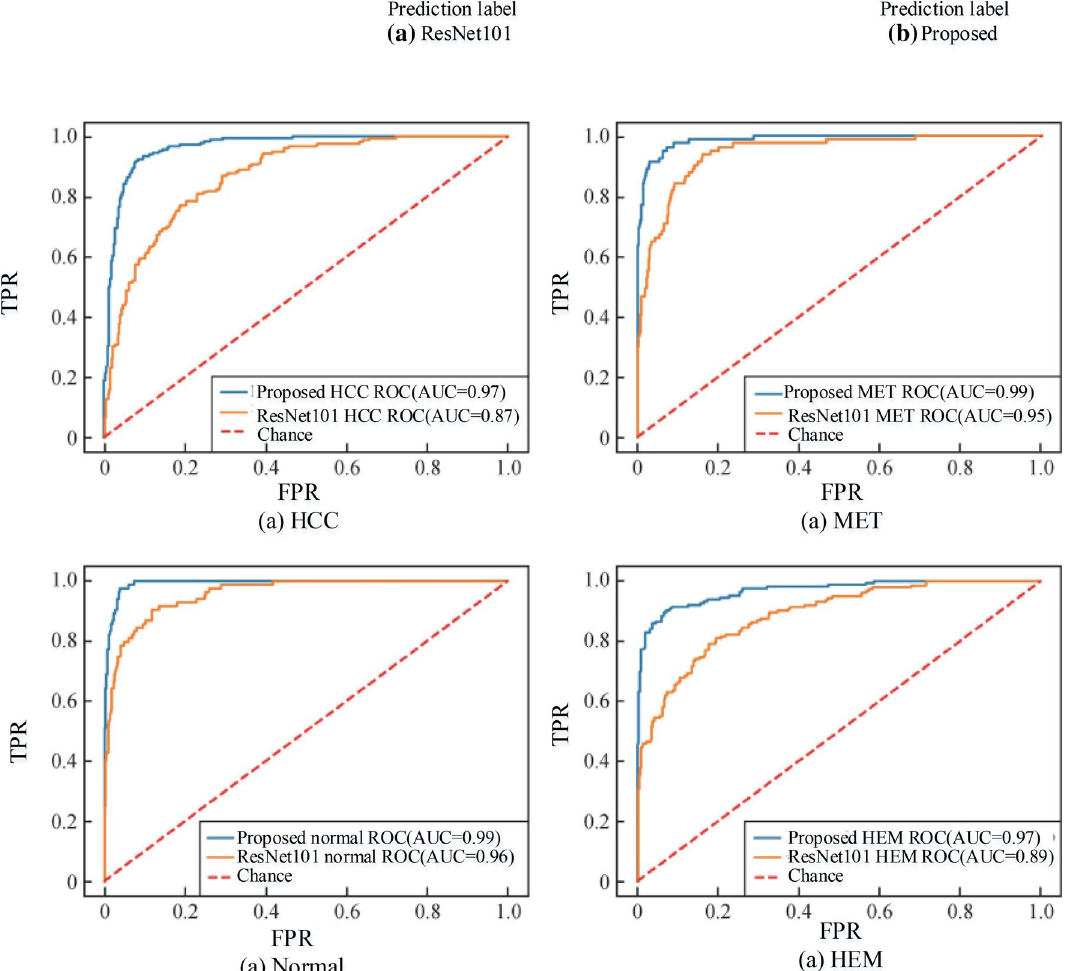
Fig. 10 ROC curves comparison of each type between ResNet101 model and proposed